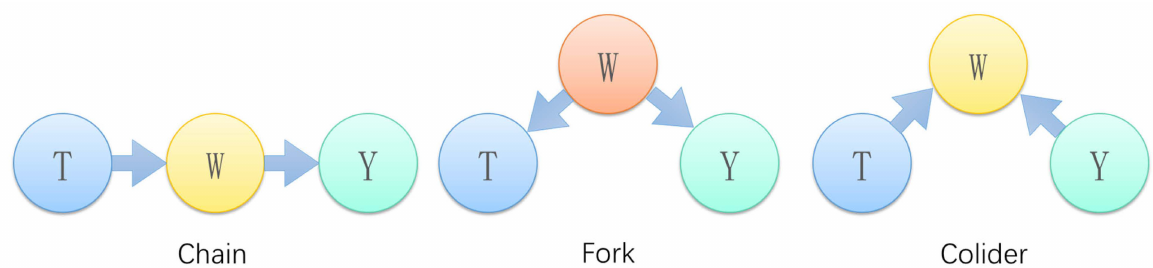
Figure 5. Diagram of three basic structures of a directed acyclic